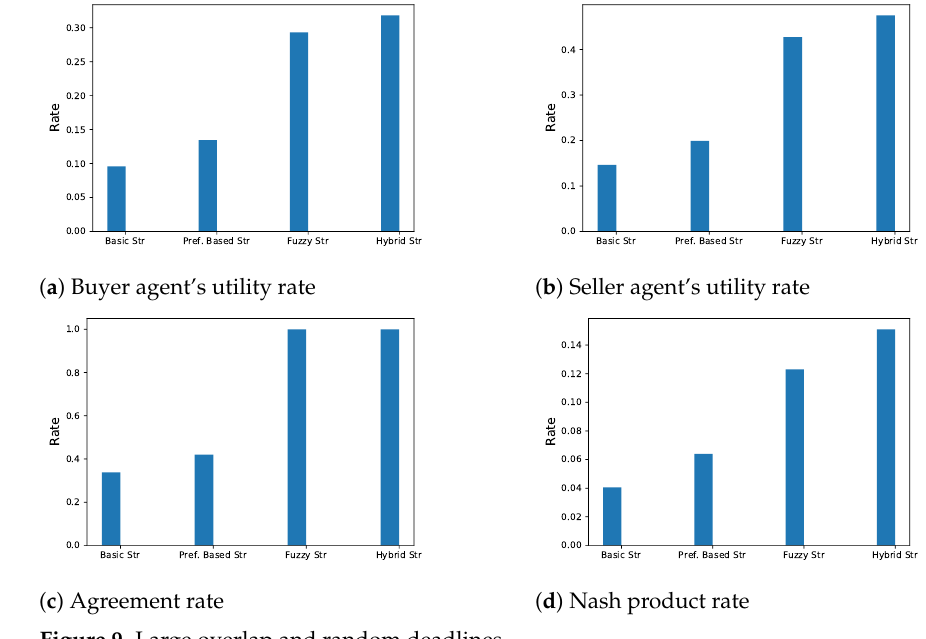
Figure 9. Large overlap and random